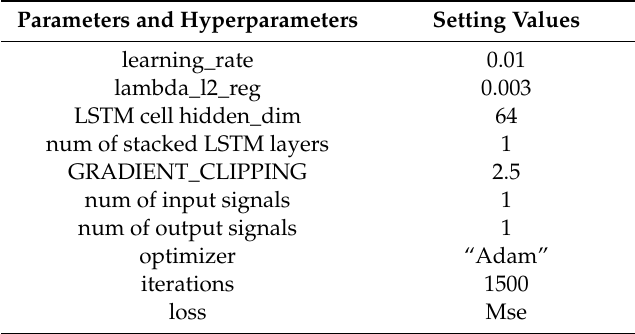
Table 2. Parameters and hyperparameters of